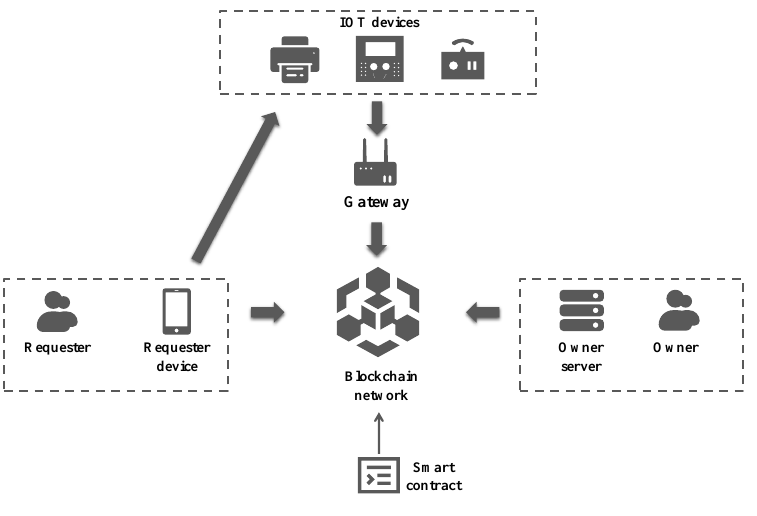
Figure 1. System